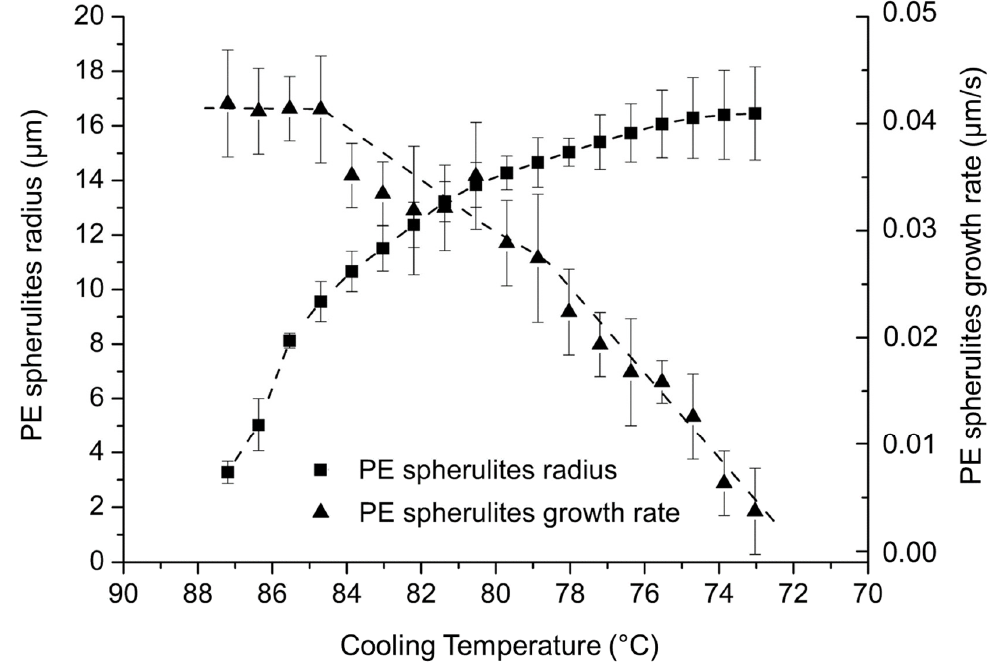
Figure 17. Evolution of the PE spherulite radius and growth rate as a function of the cooling temperature determined by optical microscopy for PE-b-PEG A.